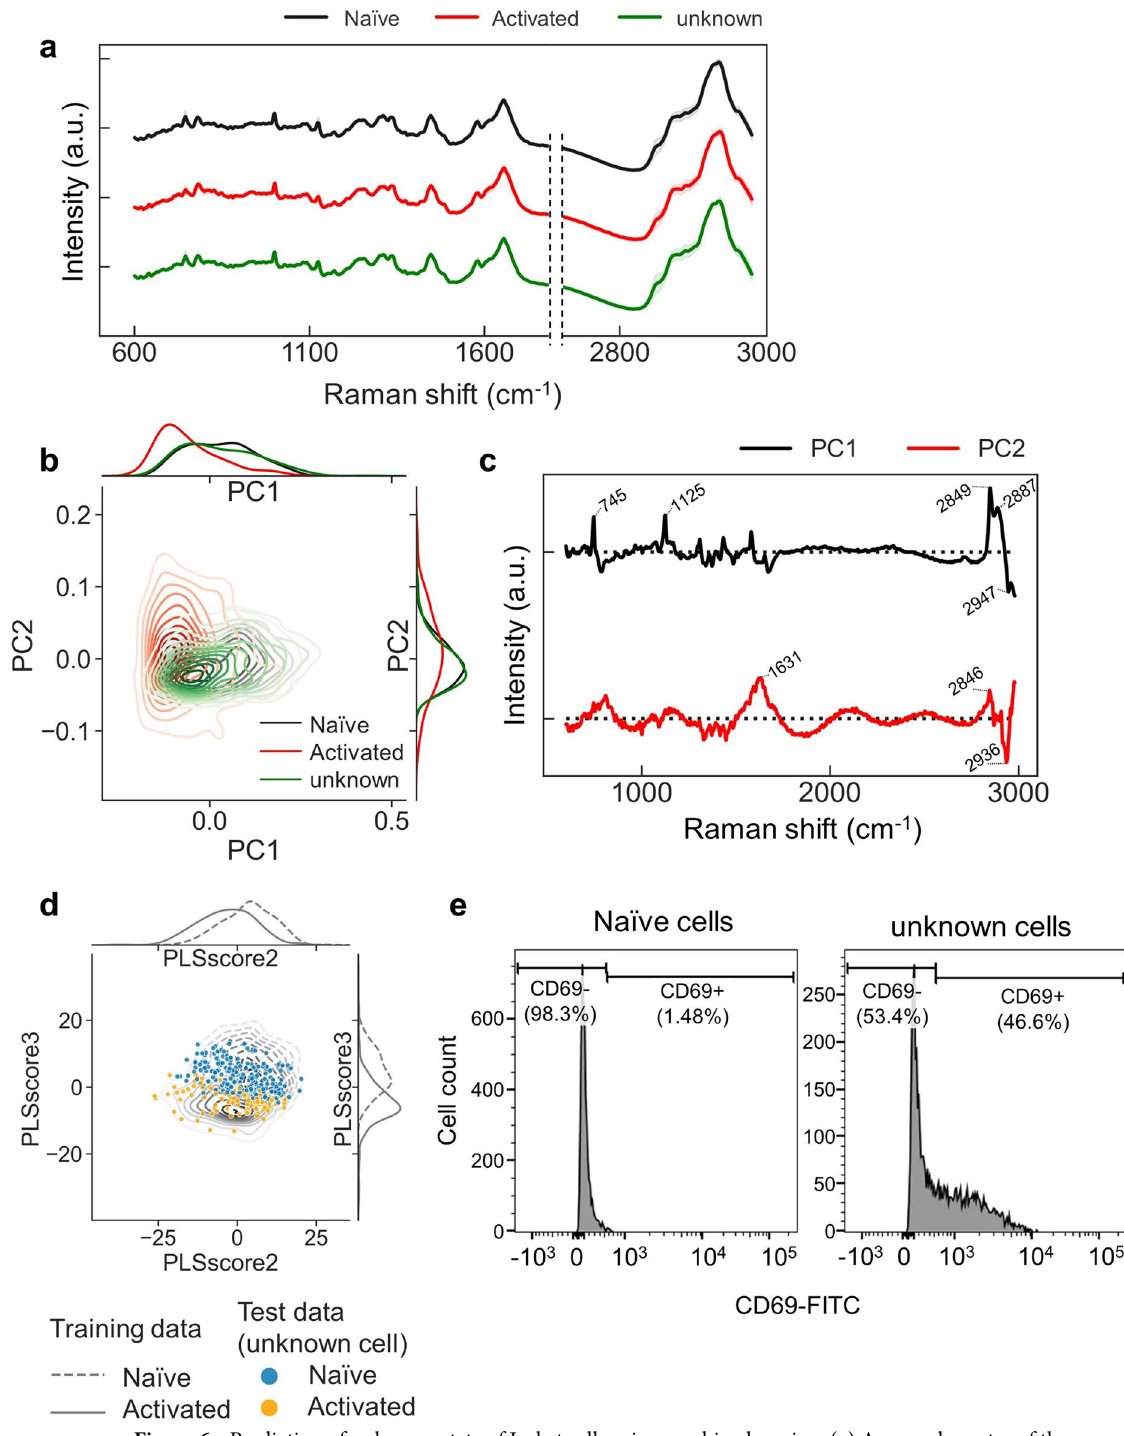
Figure 6. Prediction of unknown state of Jurkat cells using machine learning. ( a ) Averaged spectra of the analyzed region (600–3000 cm −1 ) for each cell type. SDs are shown by the shaded deviation. (naïve cells: black, activated cells: red, unknown cell: green). ( b ) Kernel density distribution diagram of the first and second principal component axes for each cell type. On the x- and y-axes, each cell type distribution density for PC1 or PC2 is shown as lines. ( c ) The first two loading vectors calculated by PCA. ( d ) Kernel density distribution diagram of the second and third PLS score for training data sets of each cell type. Naïve cells are shown as black lines, while activated cells are shown as red lines. On the x- and y-axes, the cell distribution density for PLS score2 or PLS score3 is shown as lines. Unknown cells data as test data is plotted above the kernel density distribution line of the training data (cells expected to be naïve by PLS-DA: blue, cells expected to be activated cells: orange). Each dot represents a single cell. ( e ) Flow cytometry analysis shows the rate of anti-CD69 positive cells in naïve cells and the unknown state of cells after CD3/CD28-stimulation. The x-axis in each flow cytometry plot indicates fluorescent intensity. The y-axis indicates the number of